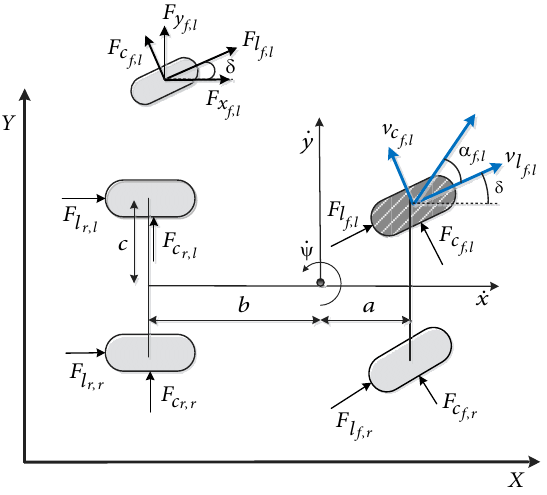
Fig. 6. The schematic diagram of vehicle model